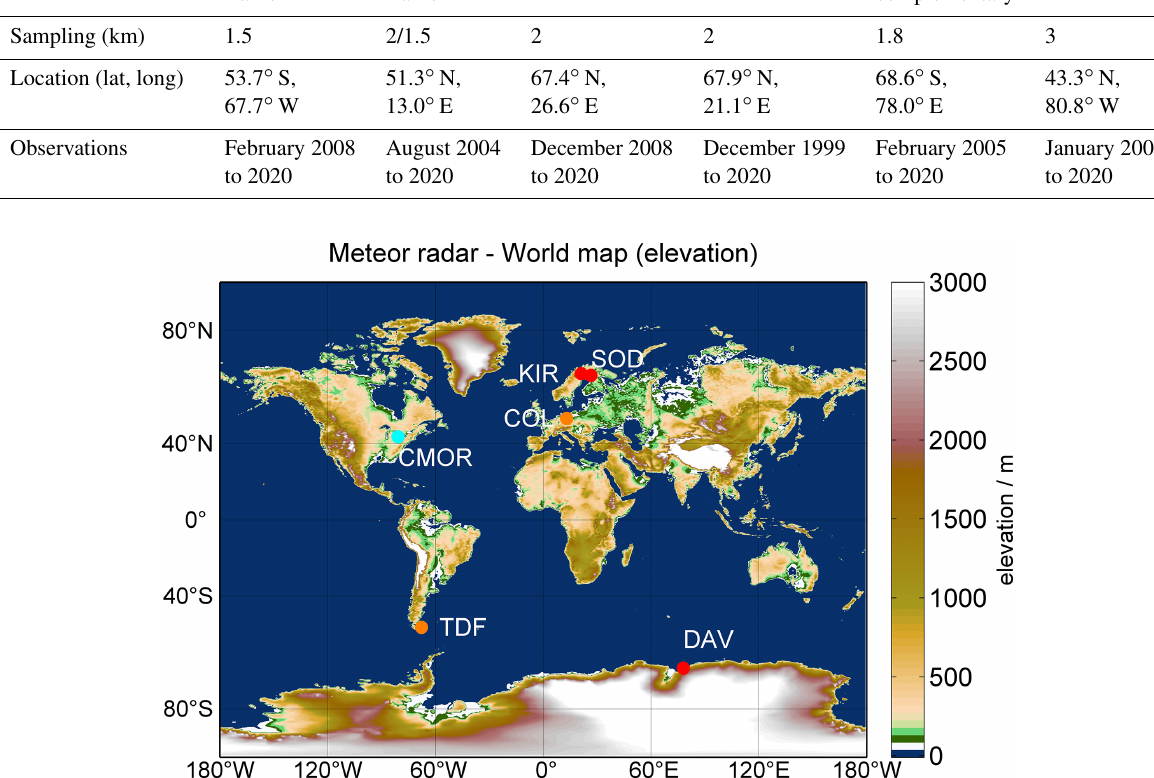
Figure 1. World map with meteor radar locations and color-coded mean elevation. Conjugate latitude stations are indicated by the same colors. The plot was generated from etopo1 using the m_map package (Amante and Eakins,